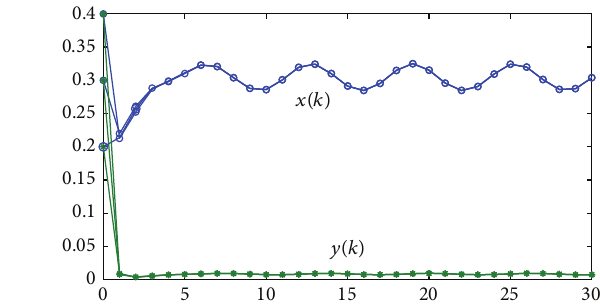
Figure 1: Dynamics behaviors of system (1) with initial conditions (𝑥(0),𝑦(0)) = (0.3,0.3), (0.4, 0.2), (0.2, 0.4) , respectively.